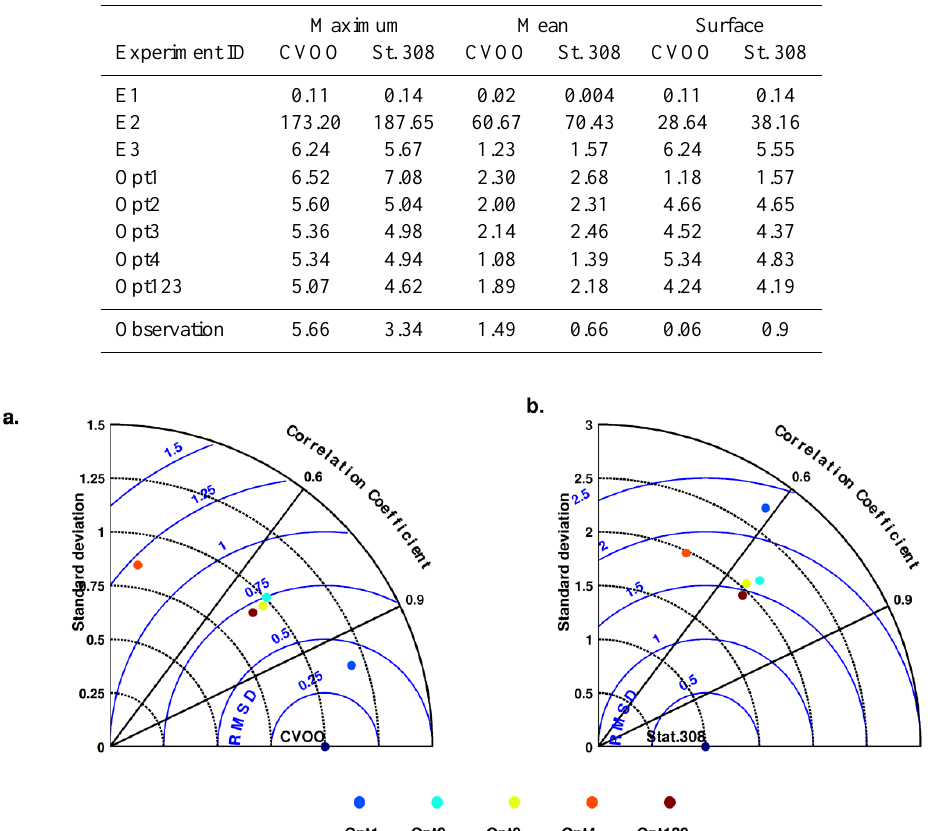
Fig. 3. Taylor diagrams for the different experiments showing the RMSD between modelled and observed profiles normalized with the observed mean concentration (blue circles), standard deviations of the individual profiles normalized with the one of the observations (black circles, ticks on the y-axis), and the linear correlation coefficient between model results and observations (angle between y- and x-axis). Note that all statistical parameters are derived from the vertical profiles, not from a time series. Observations are from CVOO (a) and St. 308 (b)